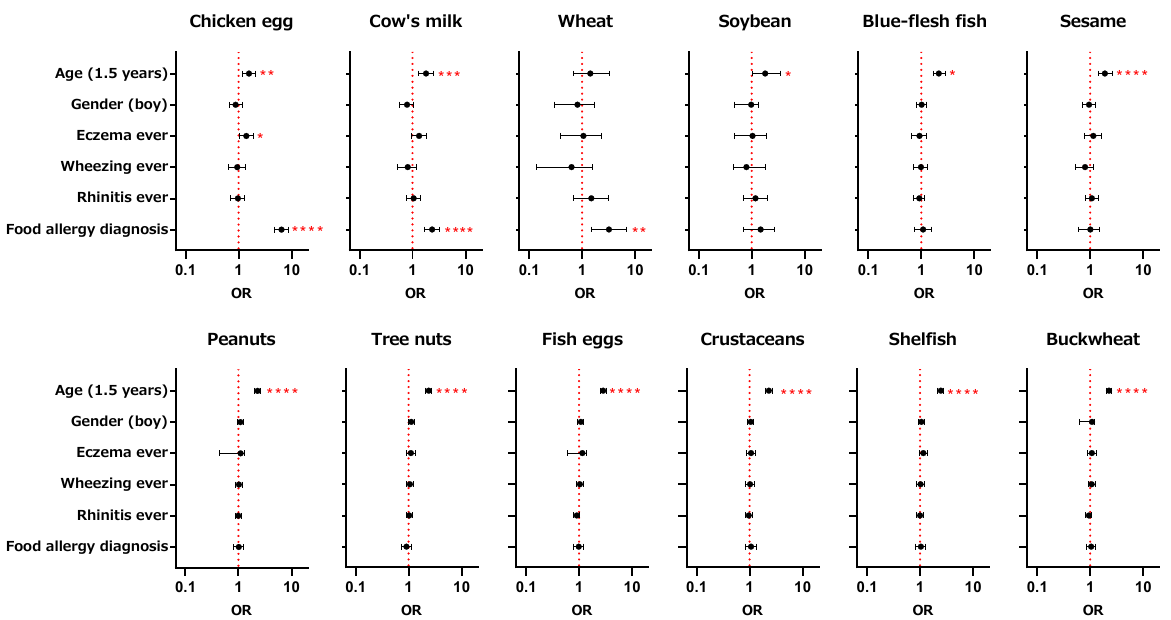
Fig. 2 Associations of food avoidance with age, gender and allergic diseases by ordinal logistic regression. Separate ordinal logistic regression models were used to determine associations between ordinal outcomes of each food avoidance and possible risk factors of food allergy. Models were adjusted for covariates including age, gender, and questionnaire-identi fi ed allergic diseases. OR: odds ratios (horizontal bars indicate 95%CI). *